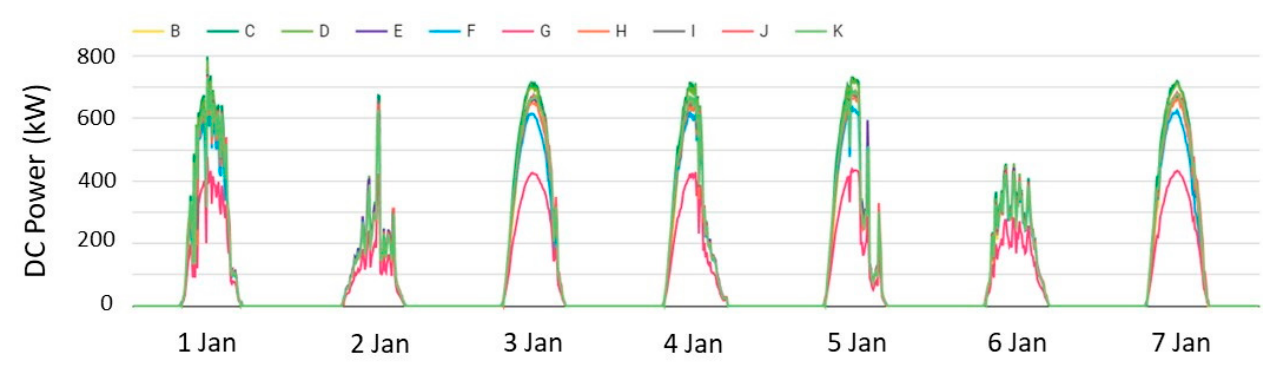
Figure 14. Signal comparison between inverters B–K (depicted by different colors) during the first week of January 2021. week of January 2021.